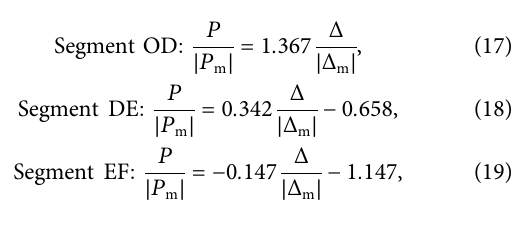
Frontiers in Materials |